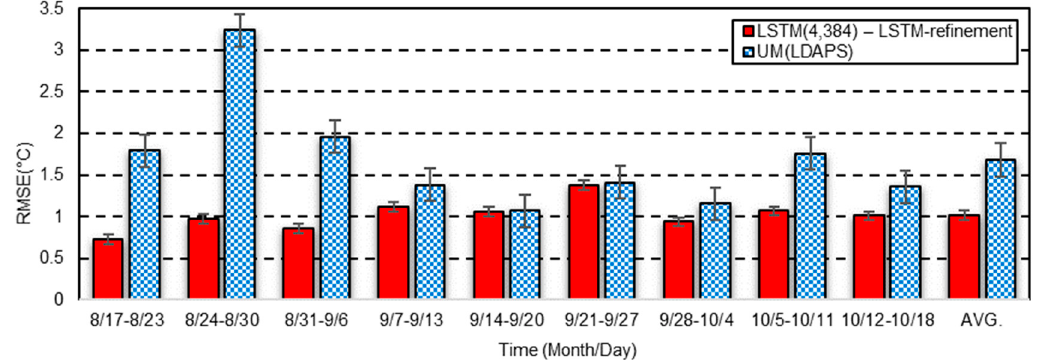
Figure 7. Weekly RMSE and MBE of the proposed LSTM-based model with LSTM-refinement and the UM LDAPS for two months from August to October in Seoul, Korea for 24 h (1 day) temperature prediction.